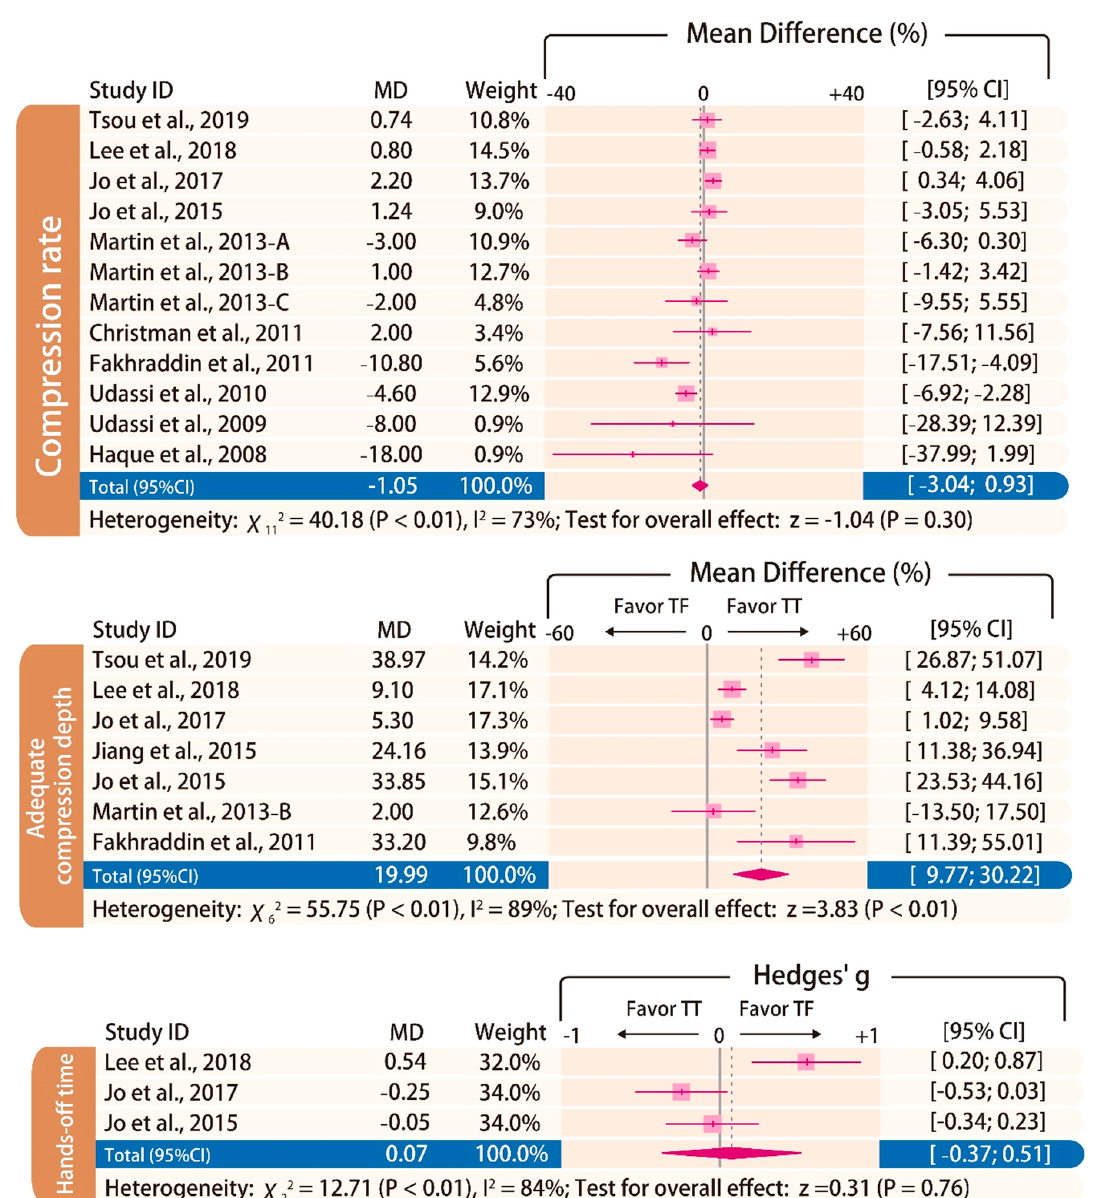
Figure 5. Forest plot of chest compression rate, proportion of adequate compression depth, and hand- off